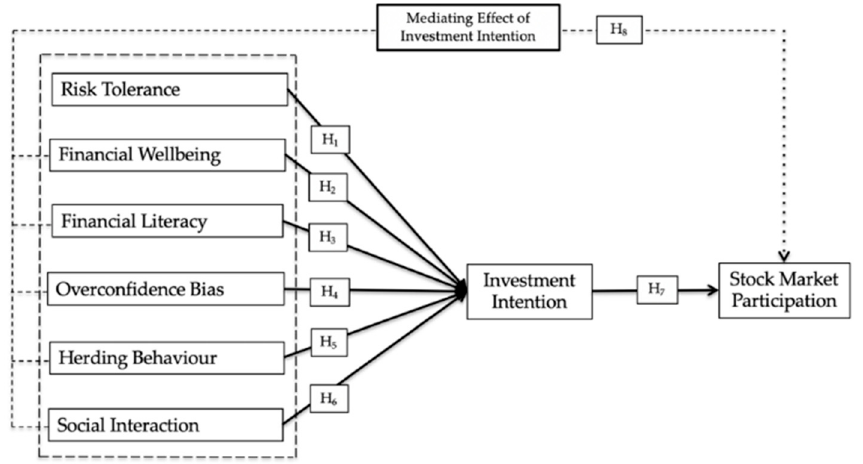
Figure 1. Research